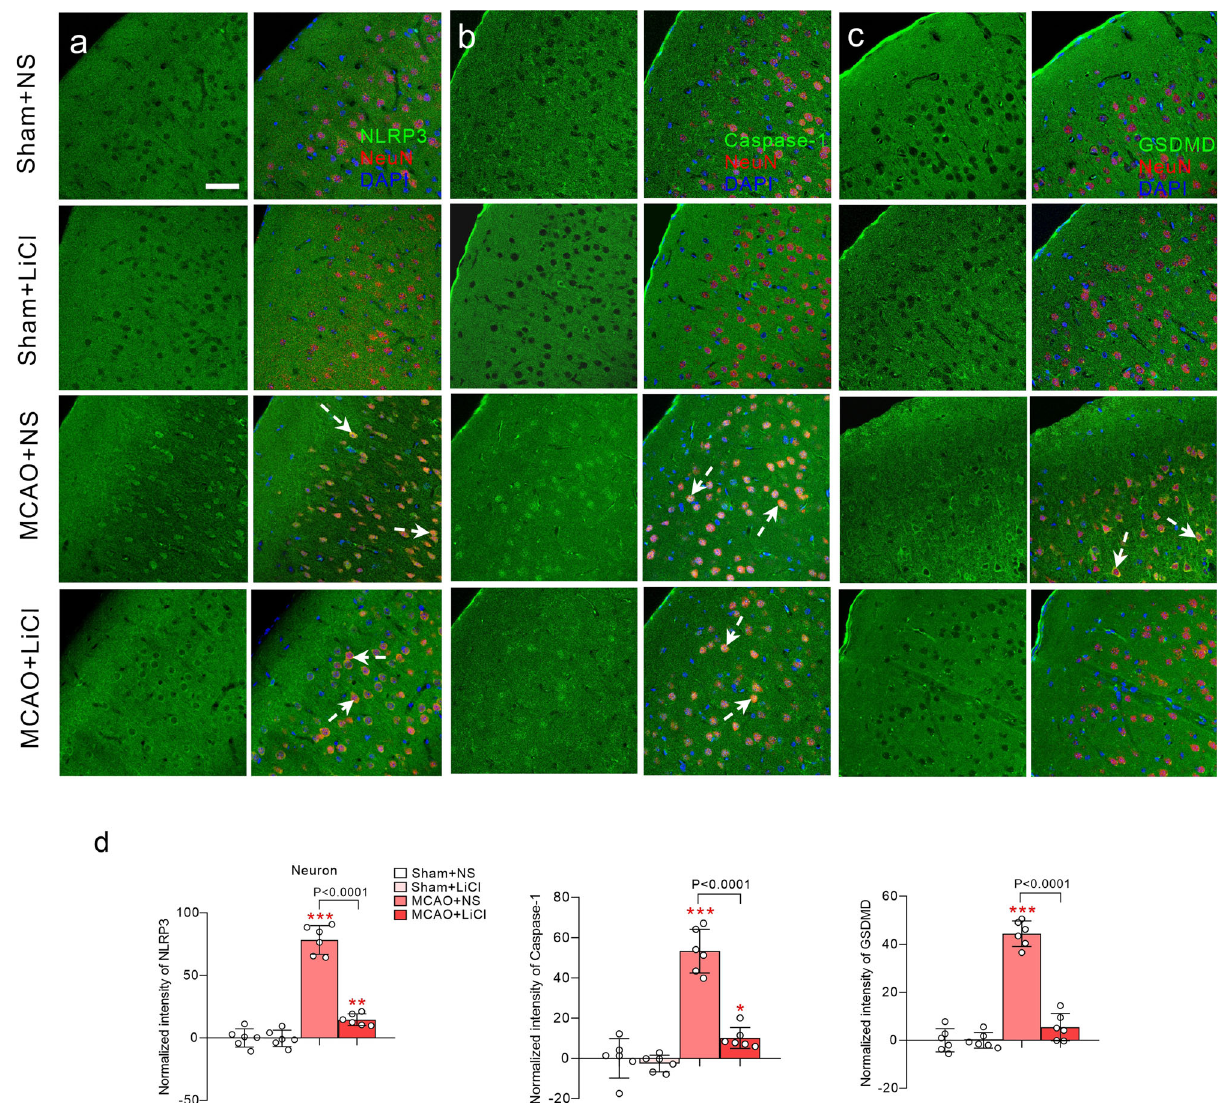
Fig. 1 LiCl suppresses neuronal activation of NLRP3 in fl ammasome and the pyroptosis related GSDMD induced by MCAO. a – c Green immuno fl uorescence of NLRP3 ( a ), caspase-1 ( b ) and GSDMD ( c ) co-stained with neuronal marker NeuN (red) and nucleus marker DAPI (blue) in the injured ipsilateral cortex. Scale bar 50 μ m. d Immuno fl uorescence intensities of NLRP3, caspase-1 and GSDMD in cortical neurones normalised to sham-NS group. The immuno fl uorescence intensities were normalised to control group and plotted as mean ± SD. N = 6 per group. One-way ANOVA for comparisons including more than two groups; unpaired two-tailed t -test for two group comparisons. * p < 0.05, ** p < 0.01, *** p <